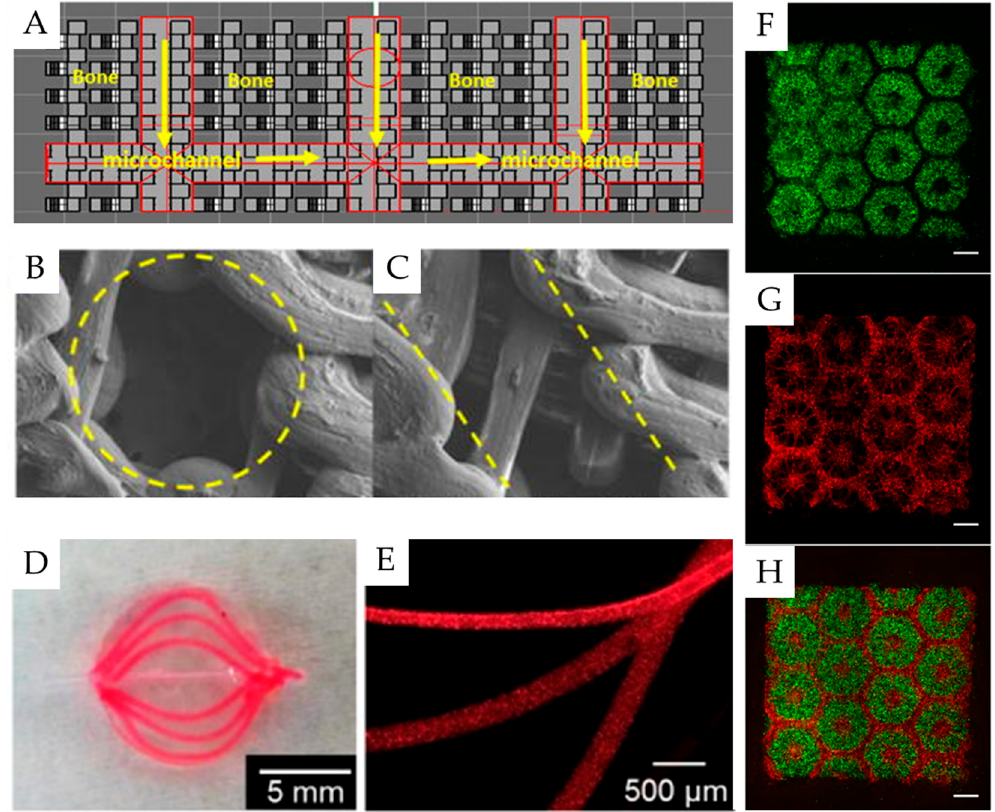
Figure 6. Examples of microstructured tissue constructs made via additive manufacturing techniques. Vascularization is a major component of functional tissue, and may be printed by leaving micron size spaces in the CAD file; 500-micron spaces are designed in this model ( A – C ) [15]. Another approach involves the printing of sacrificial material ( D , E ) [143]. Finally, tissues function depends on desired arrangement of cells, which may be achieved by direct bioprinting ( F – H ) [144]. Hepatic progenitor cells are marked in green, whereas support cells are marked in red. Scale bar: 500 µm. Vascularized, functional tissue provides better data for drug development. Reproduced with permission from Wiley ( A – C ), AIP ( D , E ), and PNAS ( F – H ).